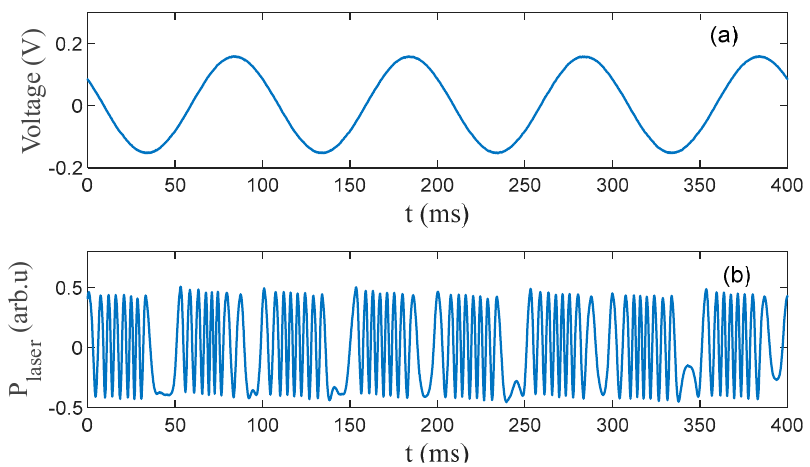
Figure 6. Experimental results of the LFI signal corresponding to out-of-plane displacement Δ z (7000 nm p–p). ( a ) The voltage obtained from the sensor monitor corresponding to displacement Δ z . ( b ) Experimental LFI signal.